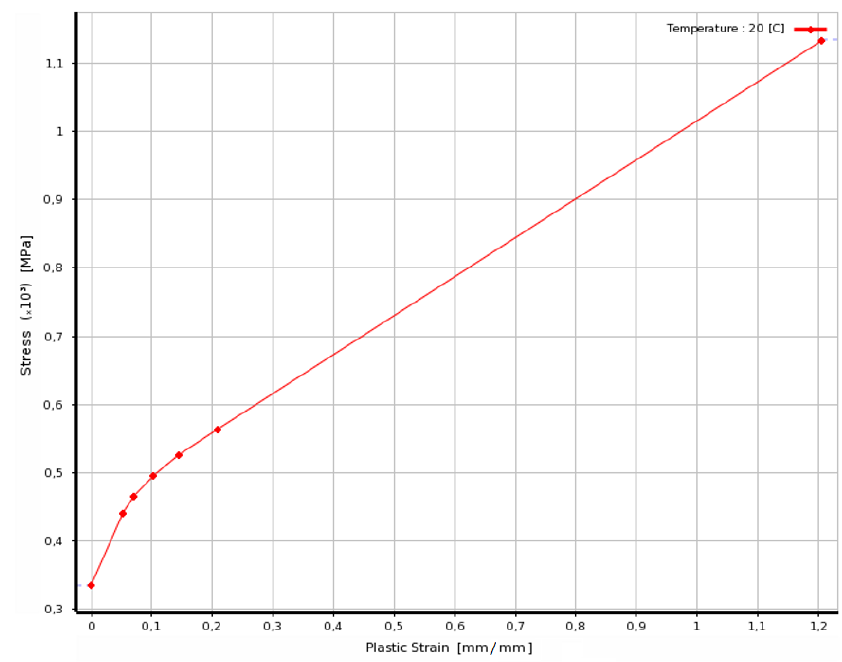
Figure 6. Stress vs. strain curve of gusset plate material, ANSYS interface.